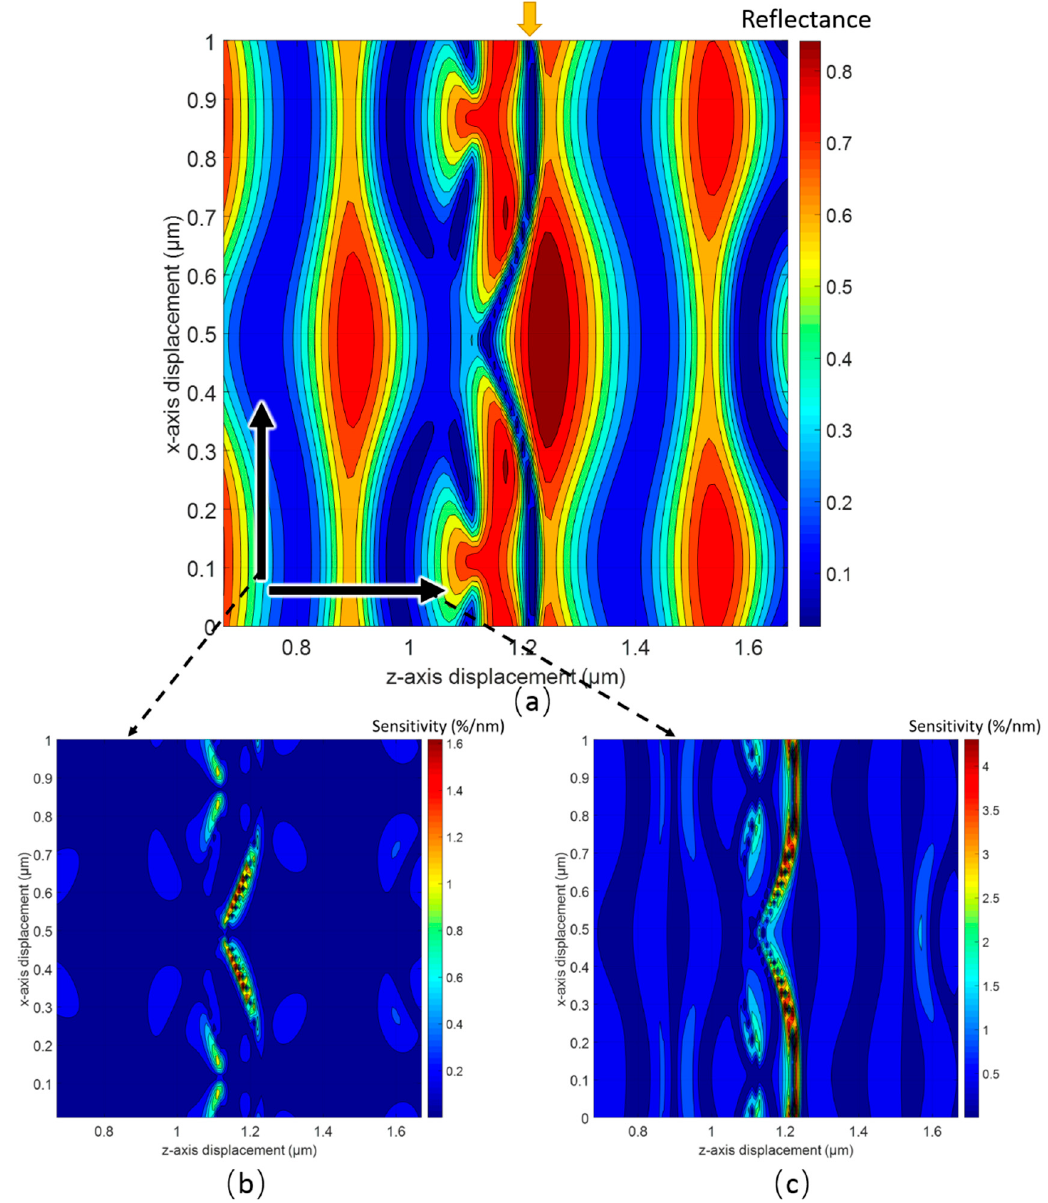
Figure 6. ( a ) Contour plot of the reflectance as a function of both in-plane and out-of-plane displacement; ( b ) contour plot of the optical sensitivity along the x -axis as a function of both in-plane and out-of-plane displacement; ( c ) contour plot of the optical sensitivity along the z -axis as a function of both in-plane and out-of-plane displacement.